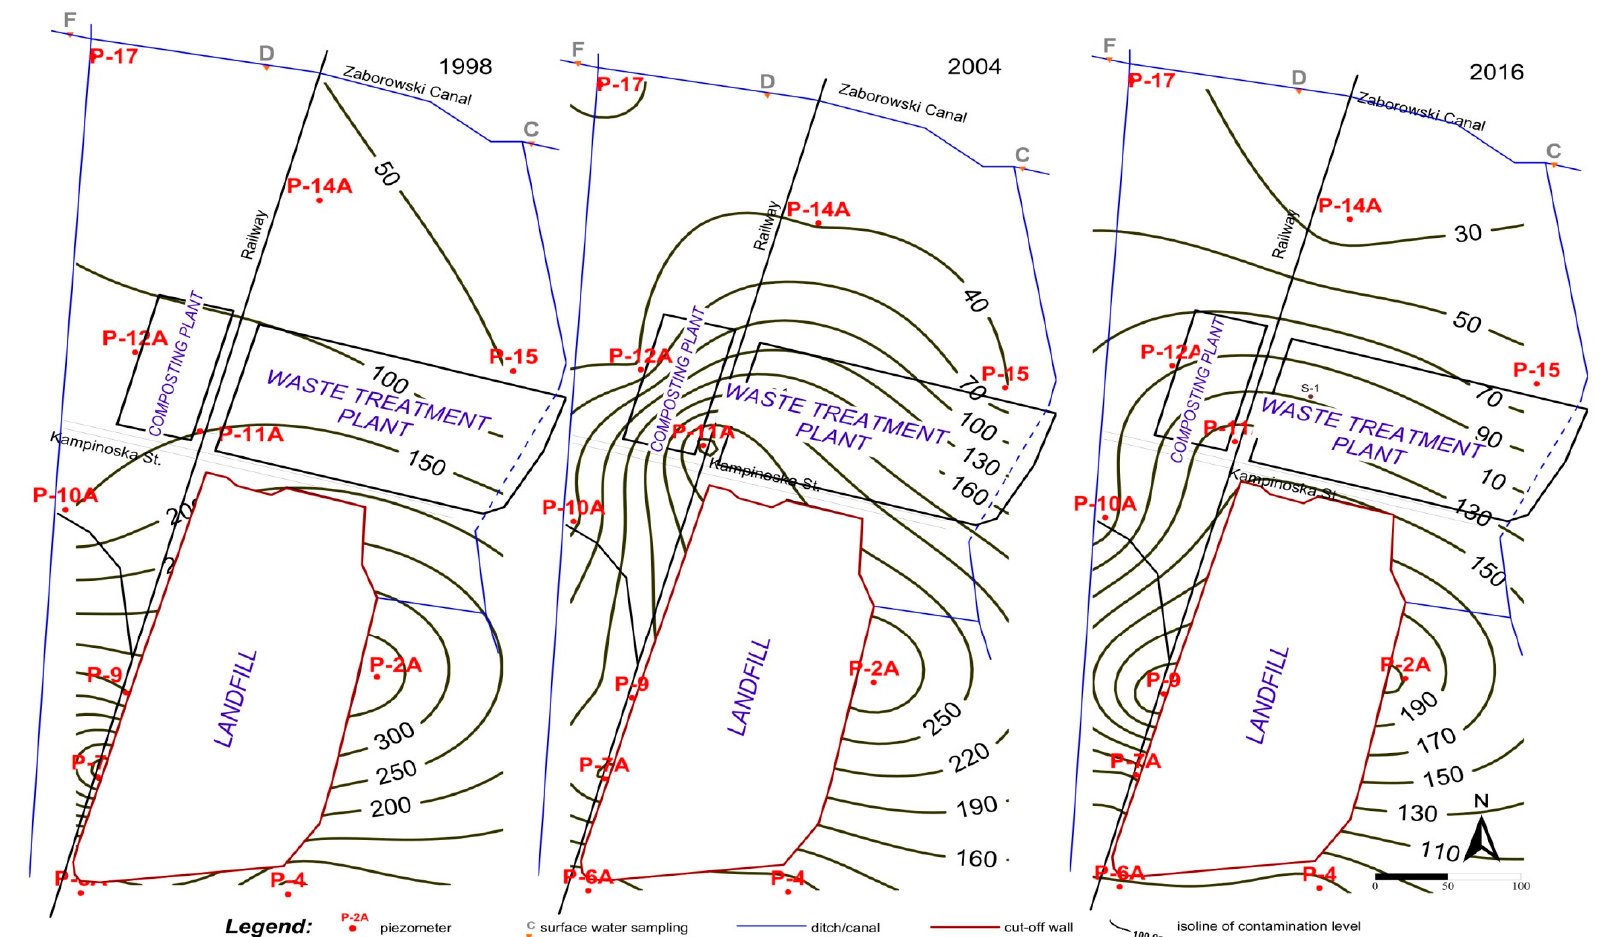
Figure 7. Distribution of the mean values of the chemical oxygen demand (COD) in groundwater in 1998, 2004 and 2016.